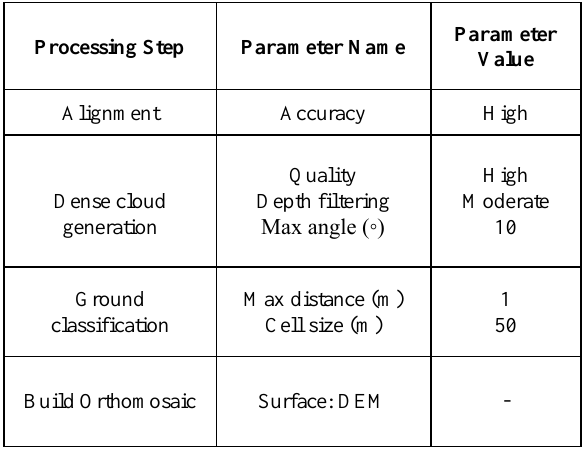
Table 2 . The most substantial processing stages and parameters